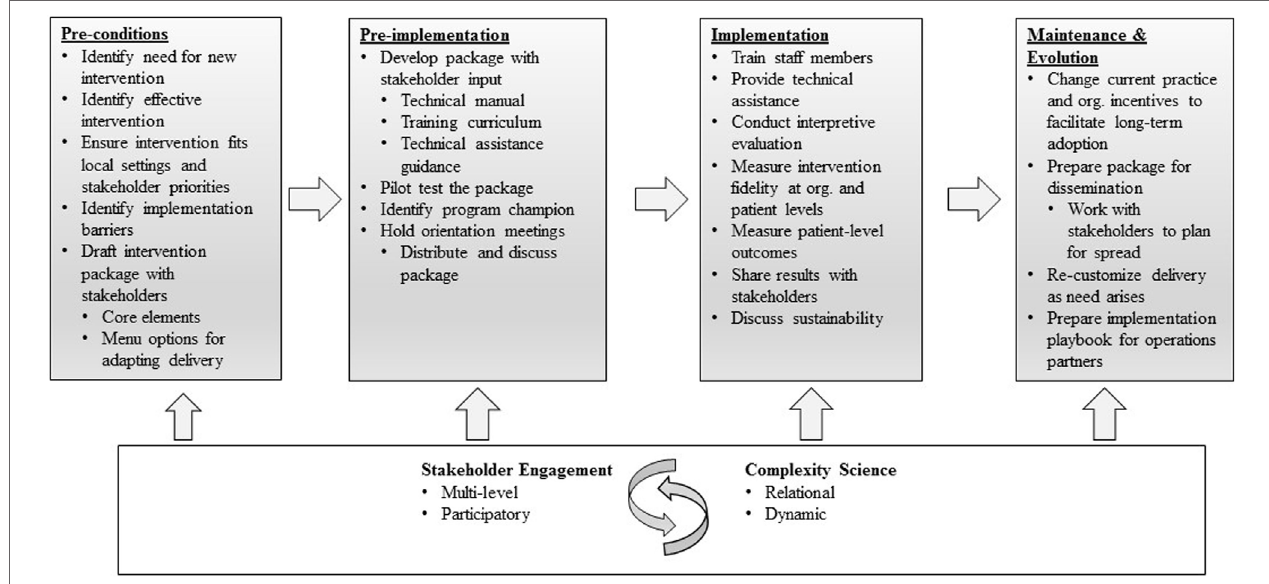
FIGURe 1 | Replicating Effective Programs Implementation Strategy*. Enhanced with stakeholder engagement and complexity science. *Adapted from Ref. (21,